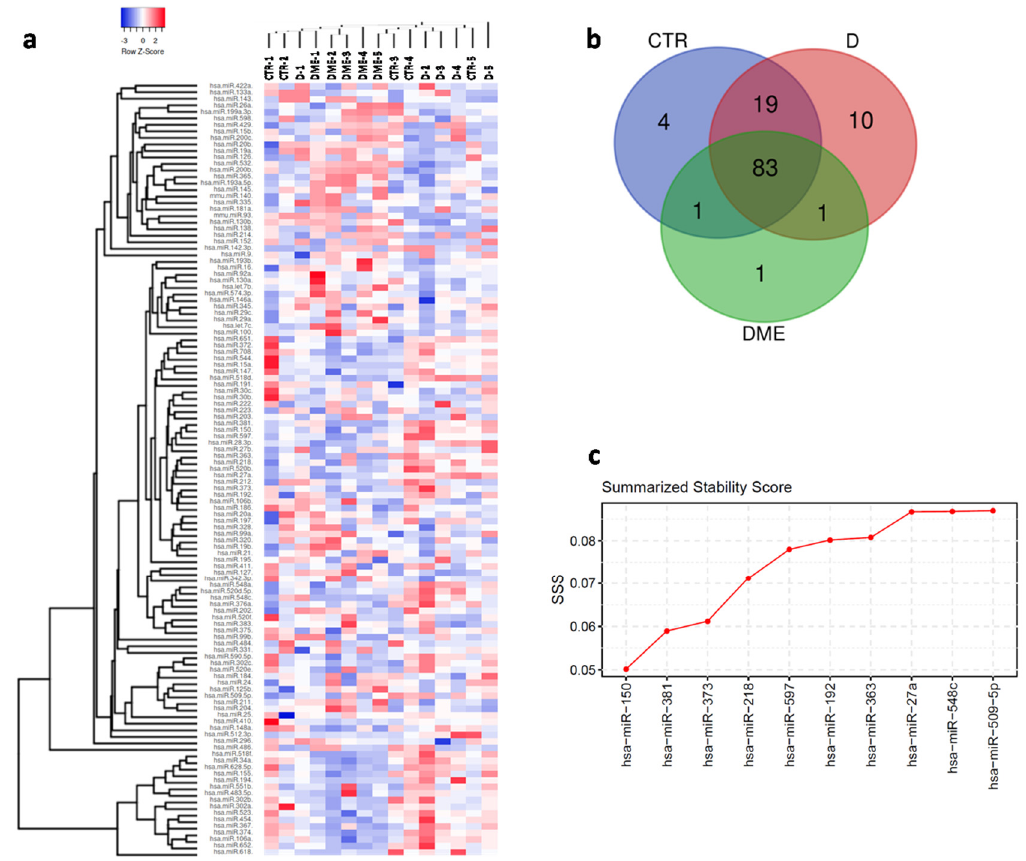
Figure 1. ( a ) Hierarchical Clustering Heatmap analysis of miRNAs detected ( n = 119) in at least 4/5 sample for each group. A total of 15 subjects were analyzed: n = 5 non diabetic controls (CTR), n = 5 type 2 diabetic patients (D) and n = 5 type 2 diabetic with Diabetic Macular Edema patients (DME). MicroRNAs expression levels are reported as scale colors based on Δ CT expression (Blue, high expression: Δ CT = − 3; Red, low expression: Δ CT = 2. ( b ) Venn diagram showing miRNAs distribution among the three groups; in particular, 83 miRNAs were common among the three groups, while 19 miRNAs were exclusively found in CTR and D but not in DME group; moreover, four miRNAs were exclusively detected in CTR groups and 10 miRNAs resulted exclusively expressed in D group, while only 1 miRNA is exclusively detected in DME group. ( c ) Stability ranking of top 10 candidate reference miRNAs based on SSS metric which combined three different assessment algorithms. Most stable miRNAs presented lowest SSS values.